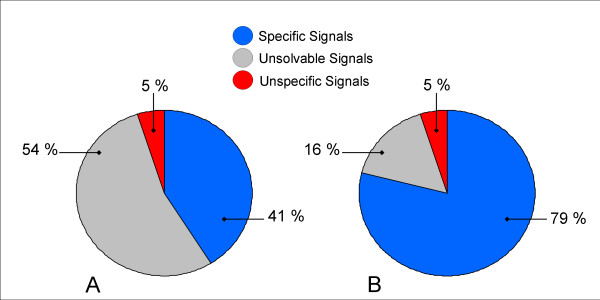
Comparison between Two-Array Method and TAMGeS. The comparison between the genotyping results of 87 samples (2,175 SNPs) by both Two-Array Method (A) and TAMGeS (B) is reported. With TAMGeS a striking reduction of the ambiguous signals (i.e. signals for which genotype assignment proves to be unfeasible, hence considered as missing signals) recovered as specific signals, can be observed. The percentage of unspecific signals (i.e. signals recorded in correspondence of alleles which result impossible according to the information given by the databases) is the same employing both the methods.